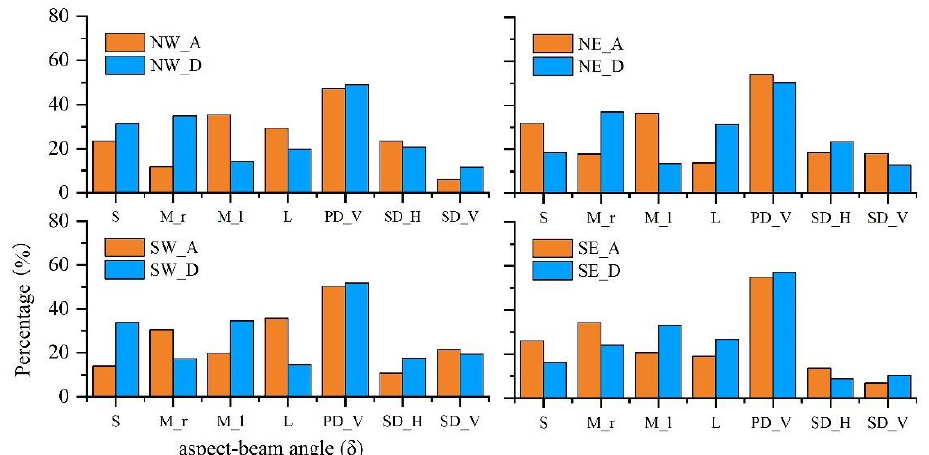
Figure 6. The statistics of the aspect-beam angle for the four glaciers. Each histogram corresponds to a glacier, with the x-axis corresponding to four subranges of the aspect-beam angle (S, M_r, M_l, L) and three secondary statistical parameters (PD_V, SD_H, SD_V), and the y-axis corresponding to the ratio of the respective pixel area to the total glacier area. The orange and blue bars indicate the ascending and descending nodes, respectively.